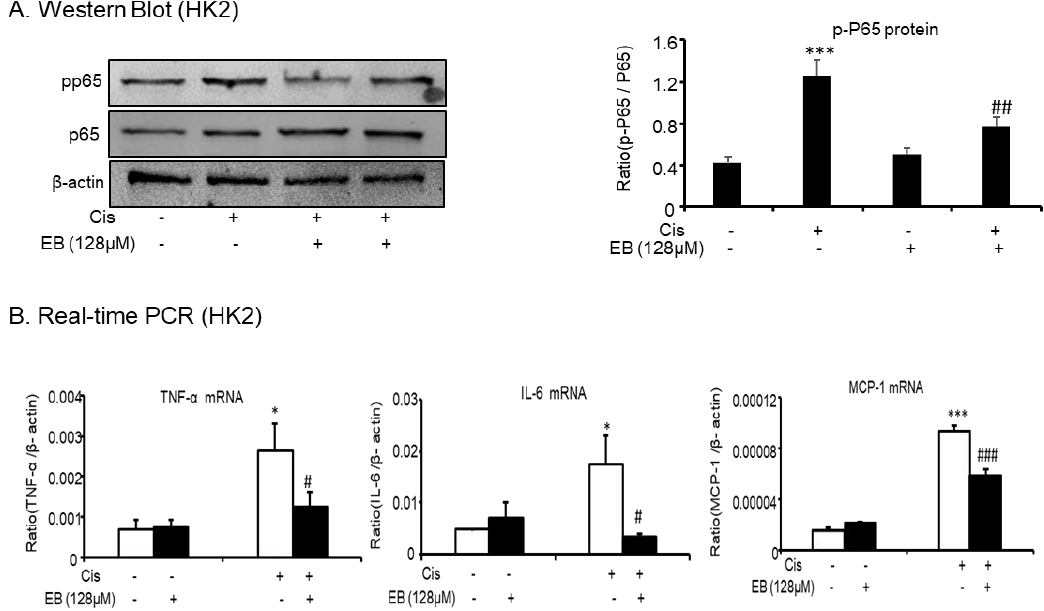
Figure 2. Eleutheroside B reduced cisplatin-induced inflammatory response in HK-2 cells. ( A ) Western blot analysis p-P65 in cisplatin-treated HK-2 cells. ( B ) Real-time PCR in HK-2 cells. Results demonstrate that eleutheroside B largely reduced cisplatin-induced mRNA levels of tumor necrosis factor (TNF)- α , monocyte chemotactic protein 1, and interleukin-6 (IL-6). Data represent the mean ± SEM for 3–4 independent experiments. * p < 0.05, *** p < 0.001 compared with control; # p < 0.05, ## p < 0.01, ### p < 0.001 compared with cisplatin-treated group. Cis, cisplatin; EB, eleutheroside